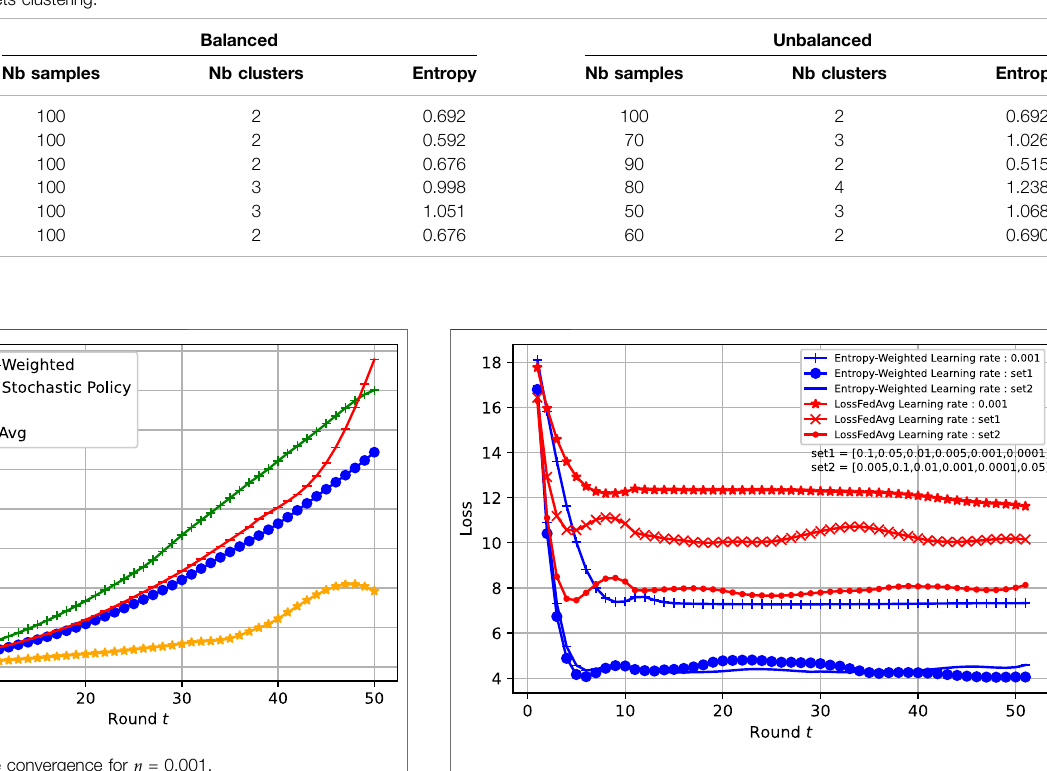
FIGURE 8 | Models convergence for heterogeneous learning rate